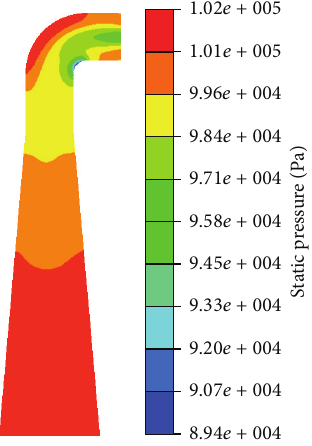
Figure 12: Static pressure contour in draft